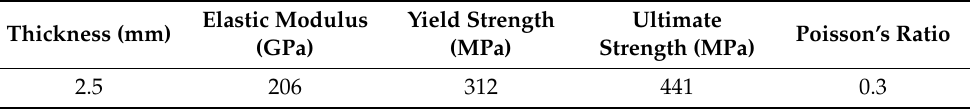
Table 4. Properties of the steel tubes.